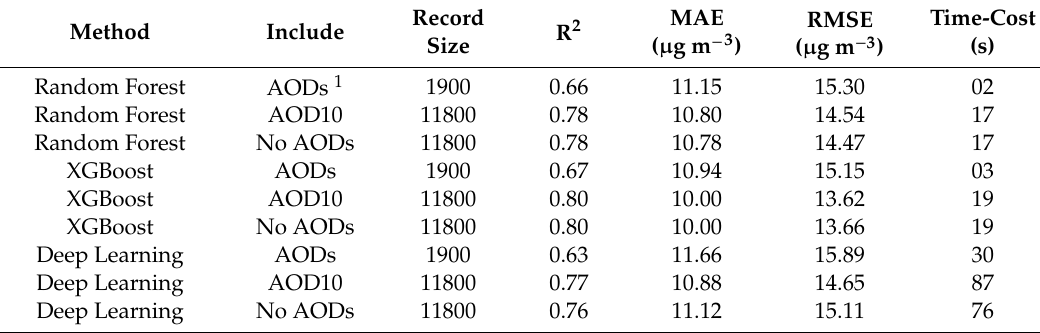
Table 5. Three machine learning methods (RF, XGBoost, and deep learning) used to predict PM 2.5 for 37 air quality monitoring stations. The R 2 , MAE, and RMSE metrics were used to evaluate the prediction accuracy. The study period was from 2015 to the end of